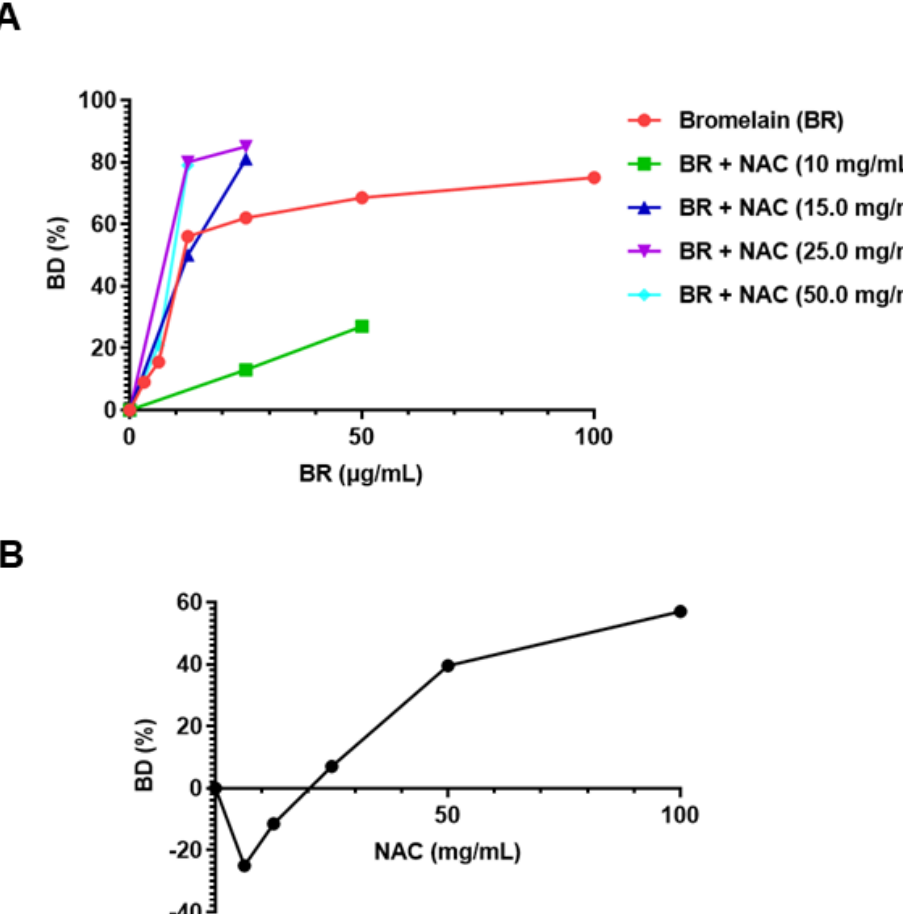
Figure 3. ( A ) Dissolution of biofilm formed by Pseudomonas aeruginosa ATCC 31461 by bromelain and